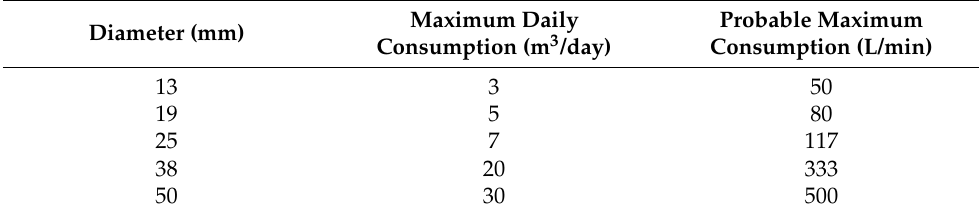
Table 4. Table of meter capacities [26].